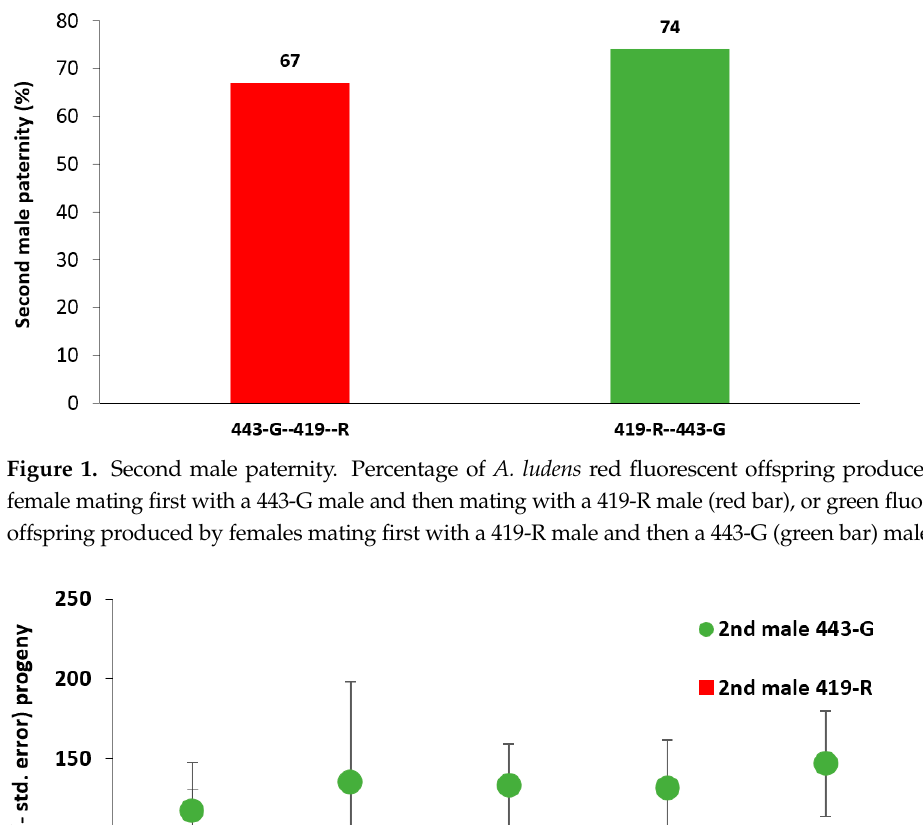
Figure 3. Mean (± std error) green or red fluorescent progeny produced over a 12-day period by A. ludens females mating either first with ( A ) 419-R male (first male P1 red bar), and a 443-G male (second male P2 green bar); or ( B ) a 443-G male (first male P1 green bar) and a 419-R (second male P2 red bar). Each bar represents progeny attributed to each male. 3.4. Induction of Sterility by Irradiated Males There was a statistically significant difference in daily fecundity based on parental combination (F = 1.495, df = 33, 902.24, Wilks Lambda = 0.8548, p = 0.0371). Post hoc tests revealed significant differences in the daily fecundity between 419-R and 443-G sterile males when they were the first male to mate, and no significant difference when they were the second male to mate. Daily fecundity was higher for females that mated first to 443-G sterile males and then remated with 419-R fertile males when compared to any of the other combinations (Figure 4). In all cases, daily fecundity and fertility were highest on the first day of oviposition and decreased with time (Figure 4).